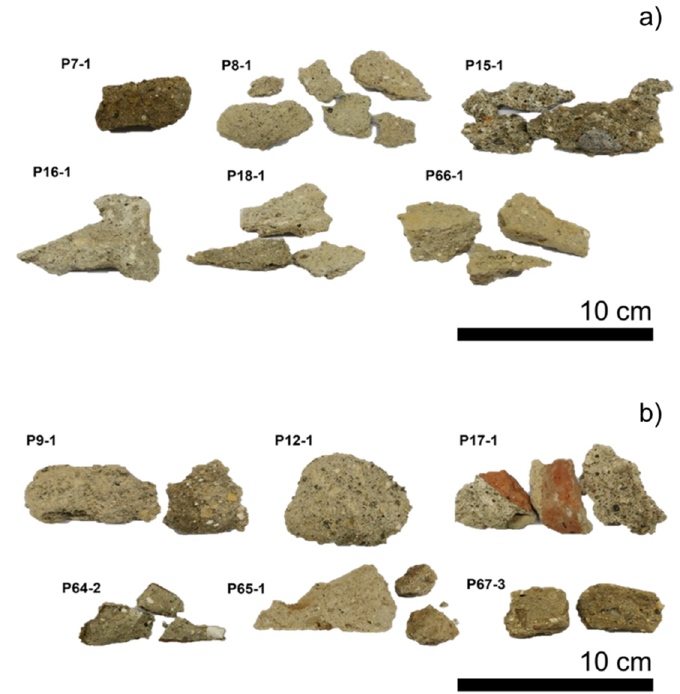
Figure 2. Macroscopic pictures of the ( a ) 1st and ( b ) 2nd century CE. examined